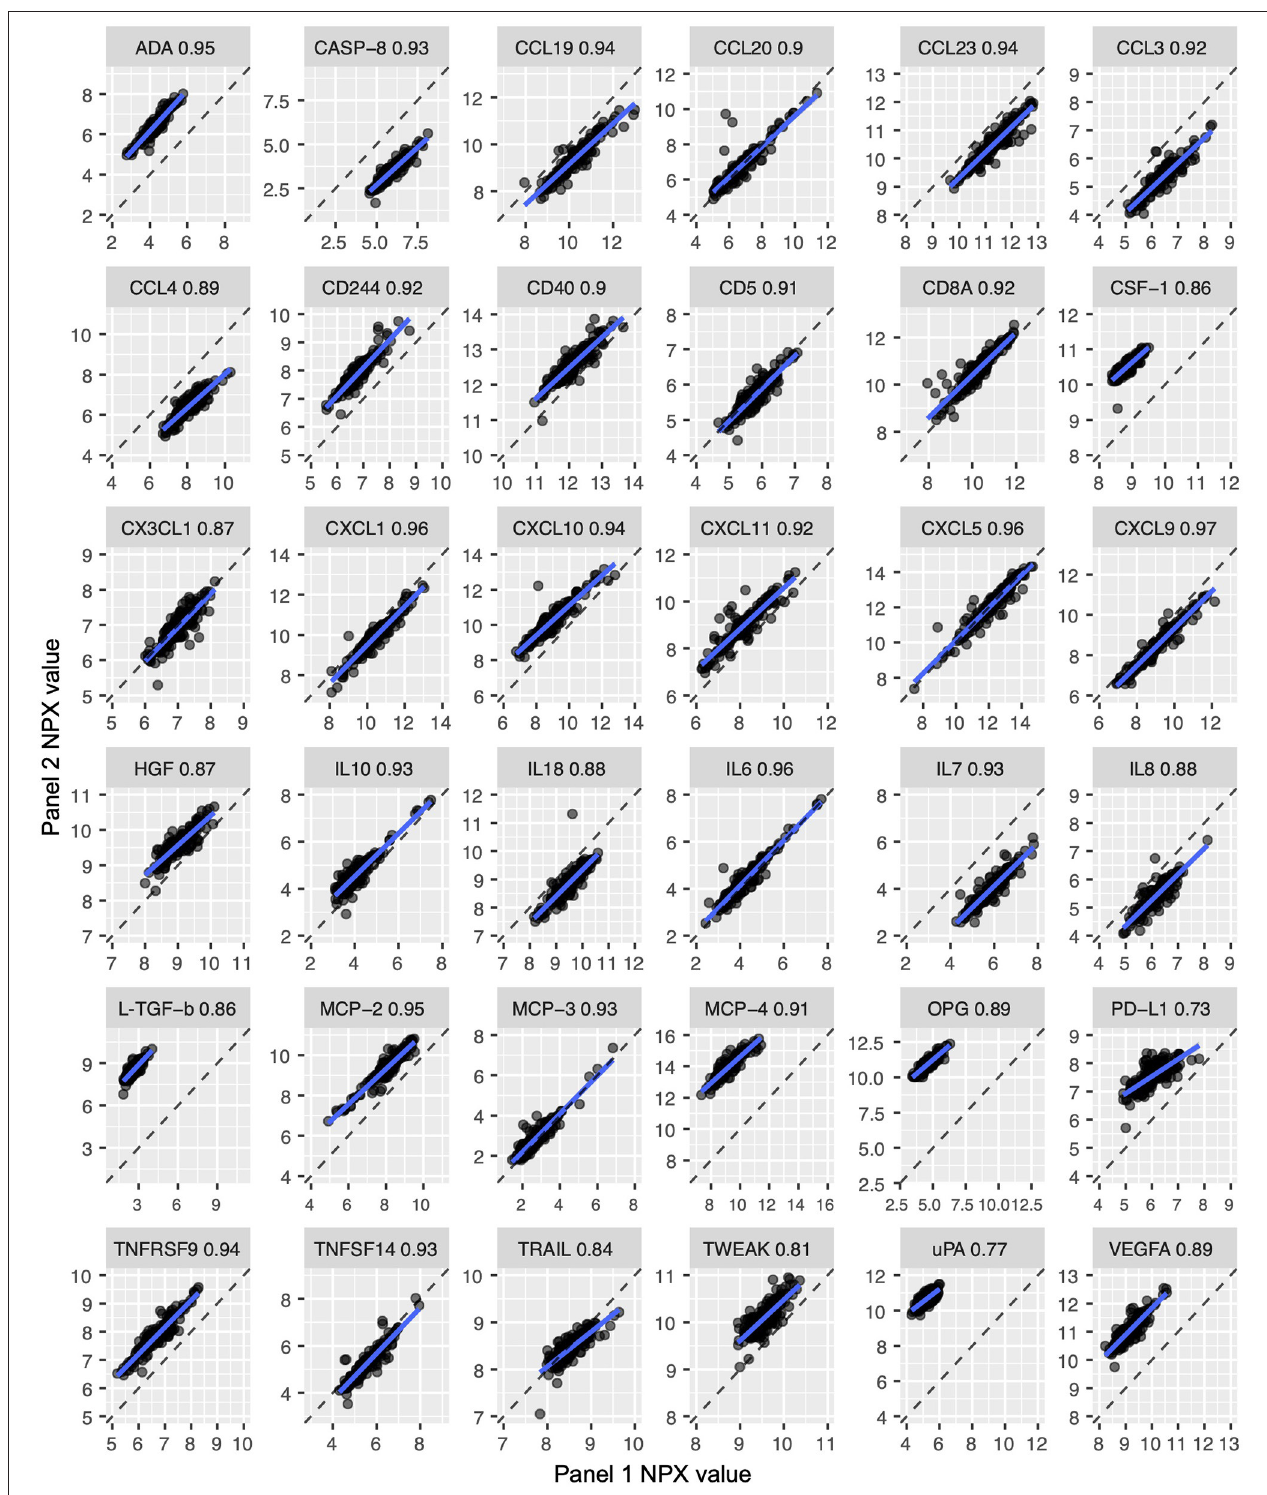
FIGURE 4 | Proteins quantified on two different panels were highly correlated. Thirty six proteins were quantified on more than one panel (for example, the ADA protein is measured on both the Immuno-Oncology and Inflammation panels), which allowed analysis of inter-panel measurement precision. Each plot shows an individual analyte’s measurements across two panels. The dashed line represents a perfect correlation of absolute values. While correlations are high (0.73–0.97), absolute values are not equivalent between panels.